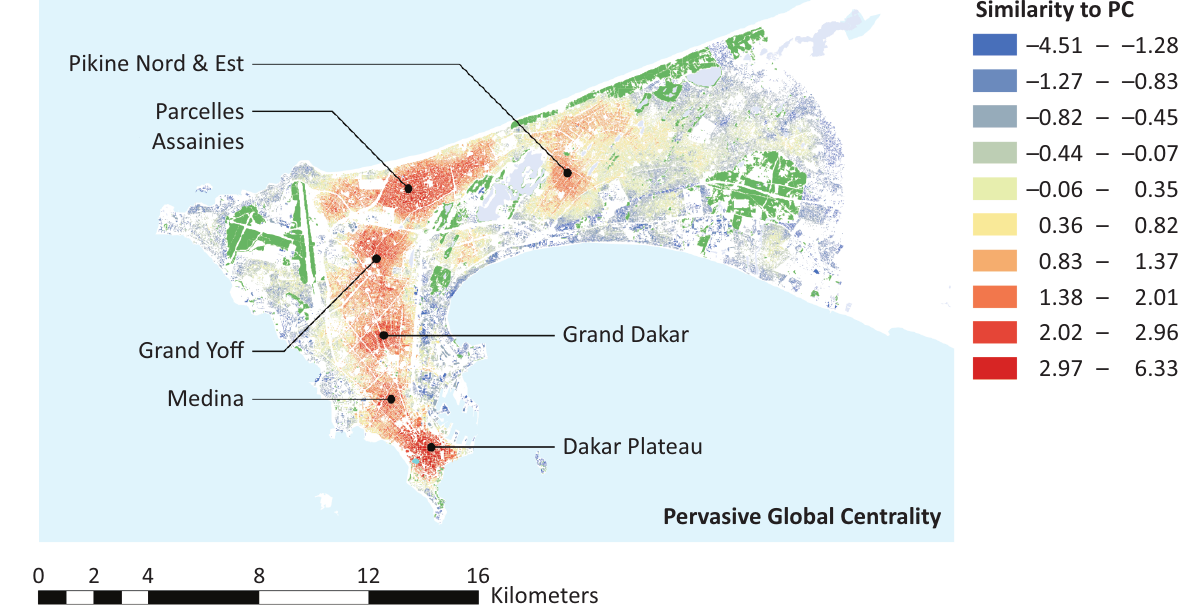
Figure 4. The use of the principal component analysis on centrality analyses conducted at multiple scales identify pervasive centers. The color coding represents (in red) the areas that are the most pervasive to the areas that are least pervasive (in blue) (Doyle, 2016b, p.